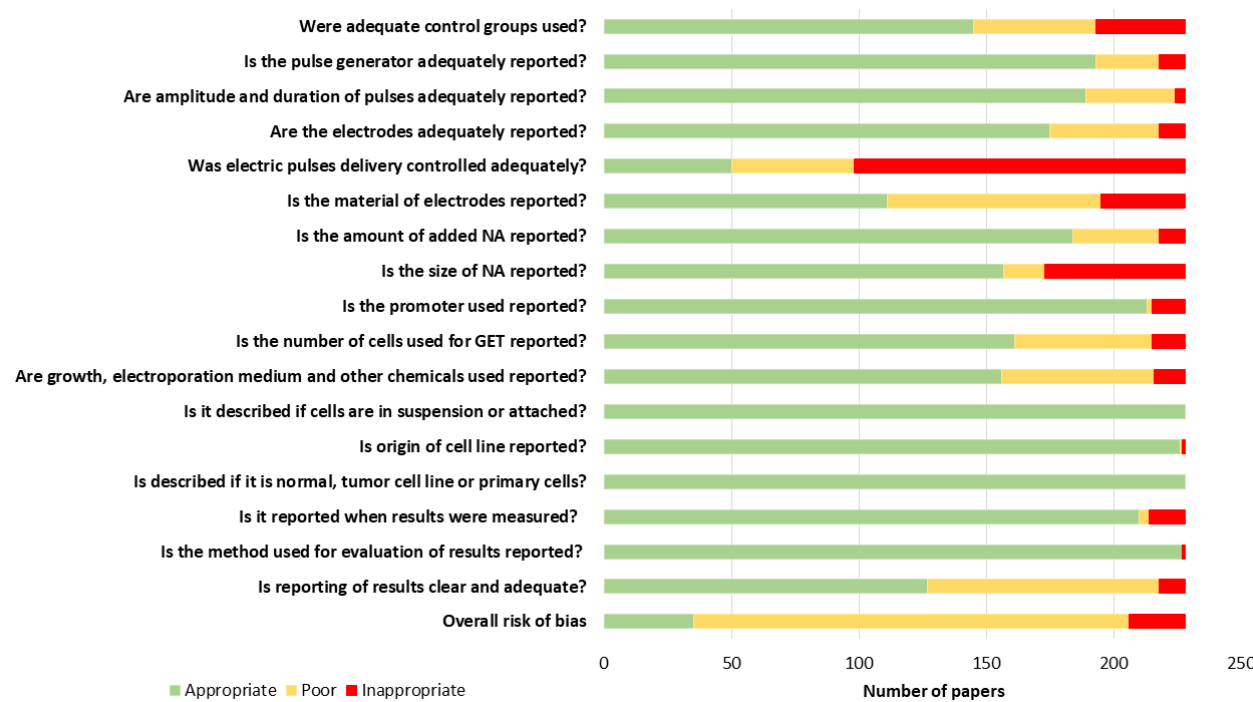
Figure 3. Reporting quality and risk of bias in all 228 papers. Because of the poor or